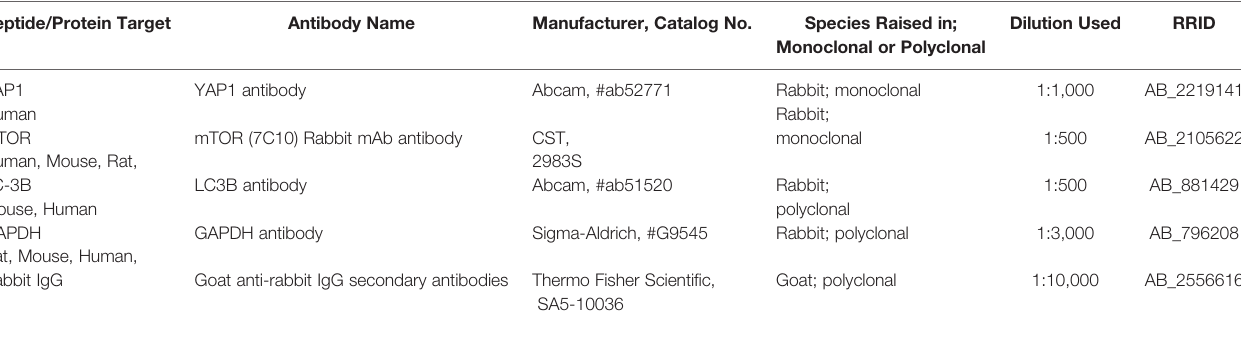
TABLE 2 | Antibodies used in this